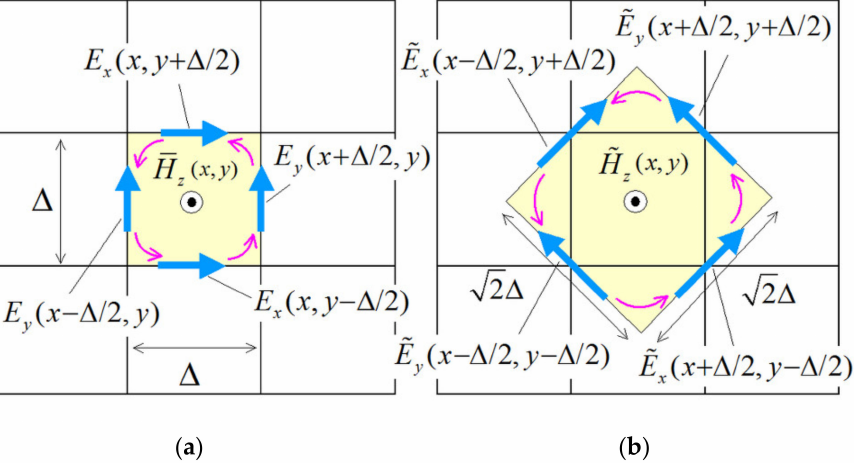
Figure 1. Integration paths on a square grid for the proposed PI model. ( a ) Basic path and ( b ) complementary path. The two paths are rotated 45 ◦ , one with respect the other, in order to mutually cancel their errors. Thus, the nodes for the coefficients of the NS-FDTD operators [2–4] are not